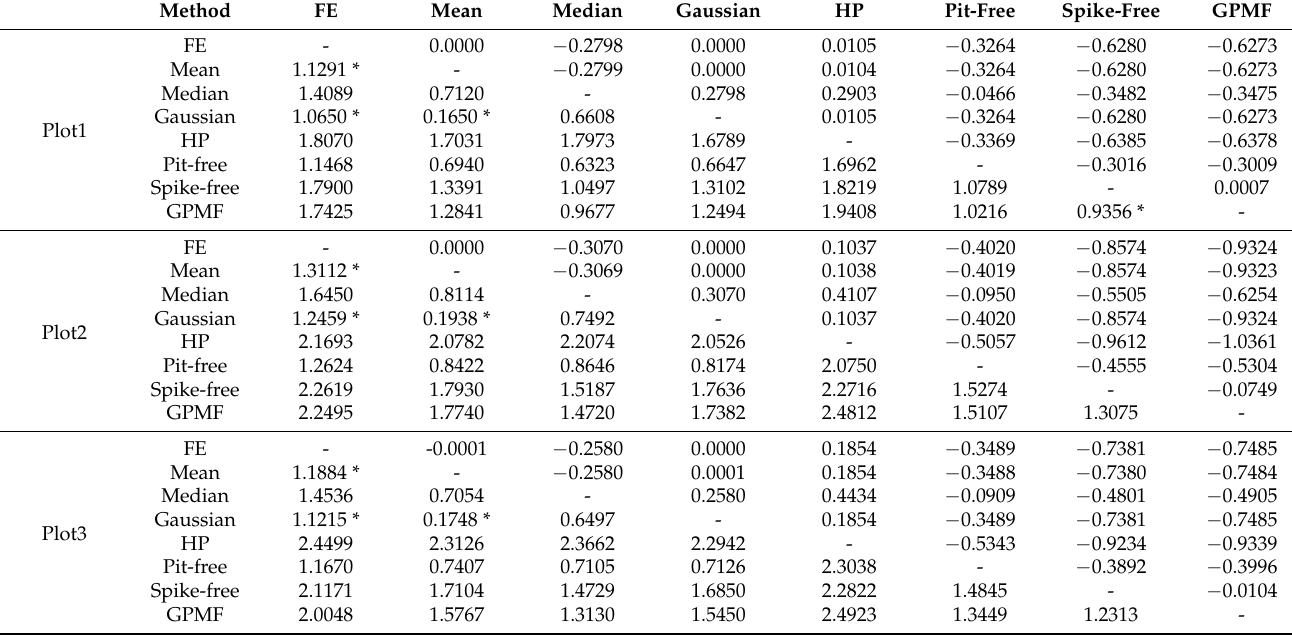
Figure 7. Profile of the UAVLS point cloud against the CHMs generated by eight methods (slice thickness is 0.1 m). Table 2. Differences across all the CHMs generated by the UAVLS point cloud. The lower left corner of the matrix is the RMSE (m), and the upper right corner of the matrix is the Bias